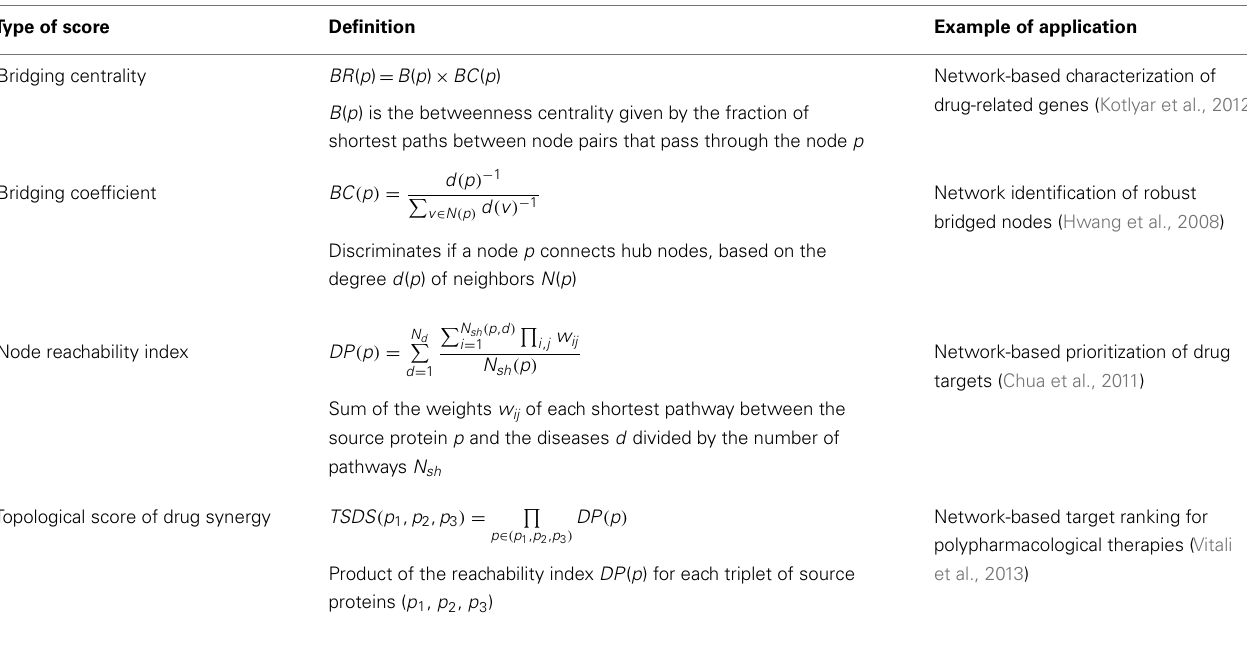
Table 1 | Synergy score estimation from network topological